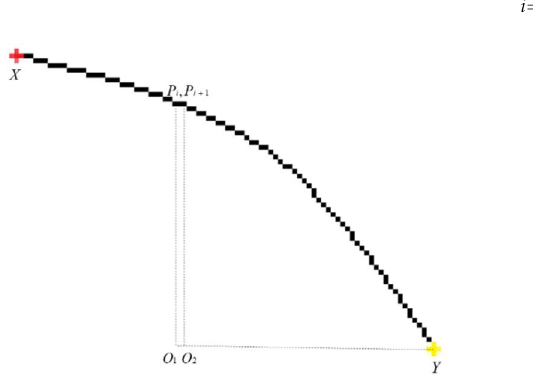
Figure 4. Manhattan distance position relationship of points on arcs. P 1 , P 2 , · · · , P N − 1 , P N is the point on the curve. PX i and PY i represent the horizontal and vertical coordinates of the i point, respectively. DirX and DirY record the direction of the end point relative to the start point. FalseNum indicates the number of times the curve does not follow the trend. When FalseNum ≥ n × η (the value of η ; see 4.1), these arcs are considered to be noise or unimportant information, and we remove them from the image. The results obtained by our algorithm are shown in Figure 5.